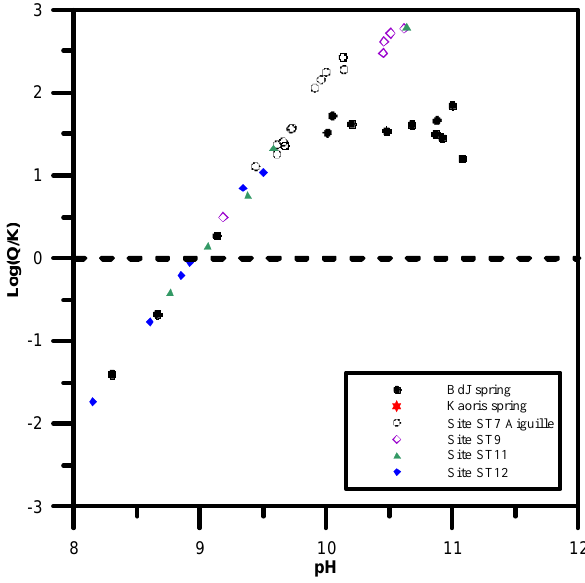
Figure 8. The brucite saturation state of Prony waters versus pH. Same symbols as in Fig. 5. The horizontal dashed line represents the chemical